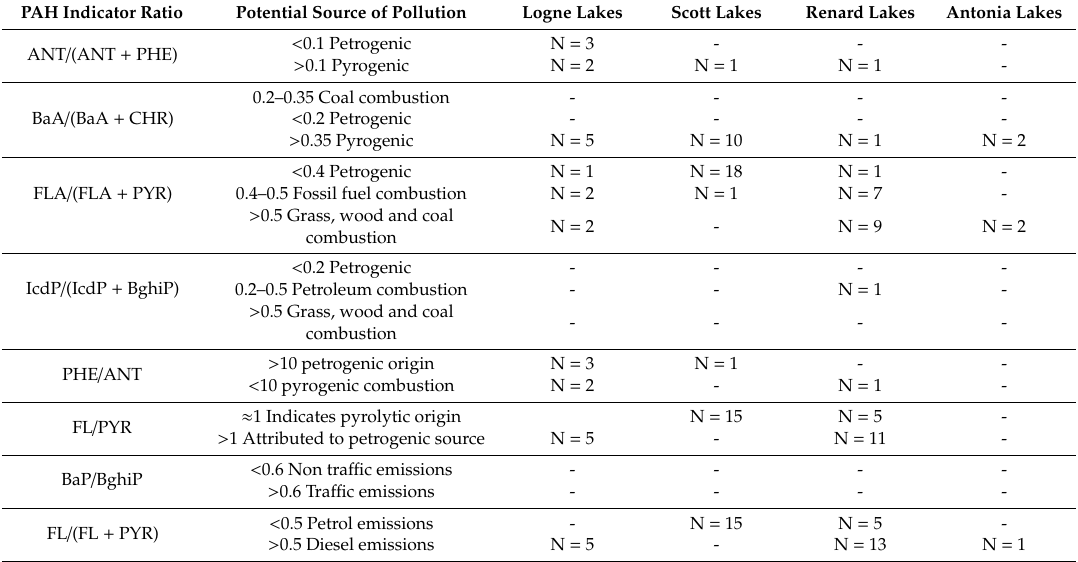
Table 3. PAH indicator ratio for surface water samples of 54 lakes collected in NW Wedel Jarlsberg Land. PAH Indicator